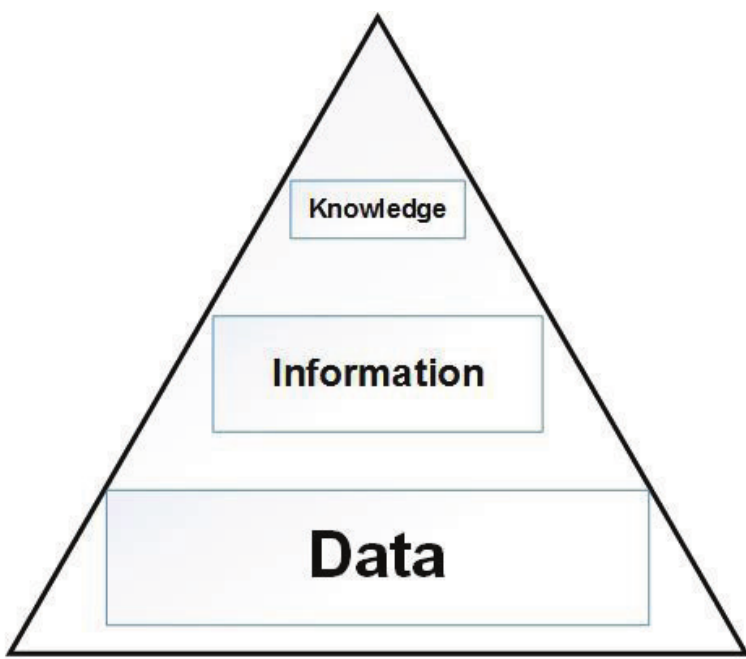
Figure 1. Informatics